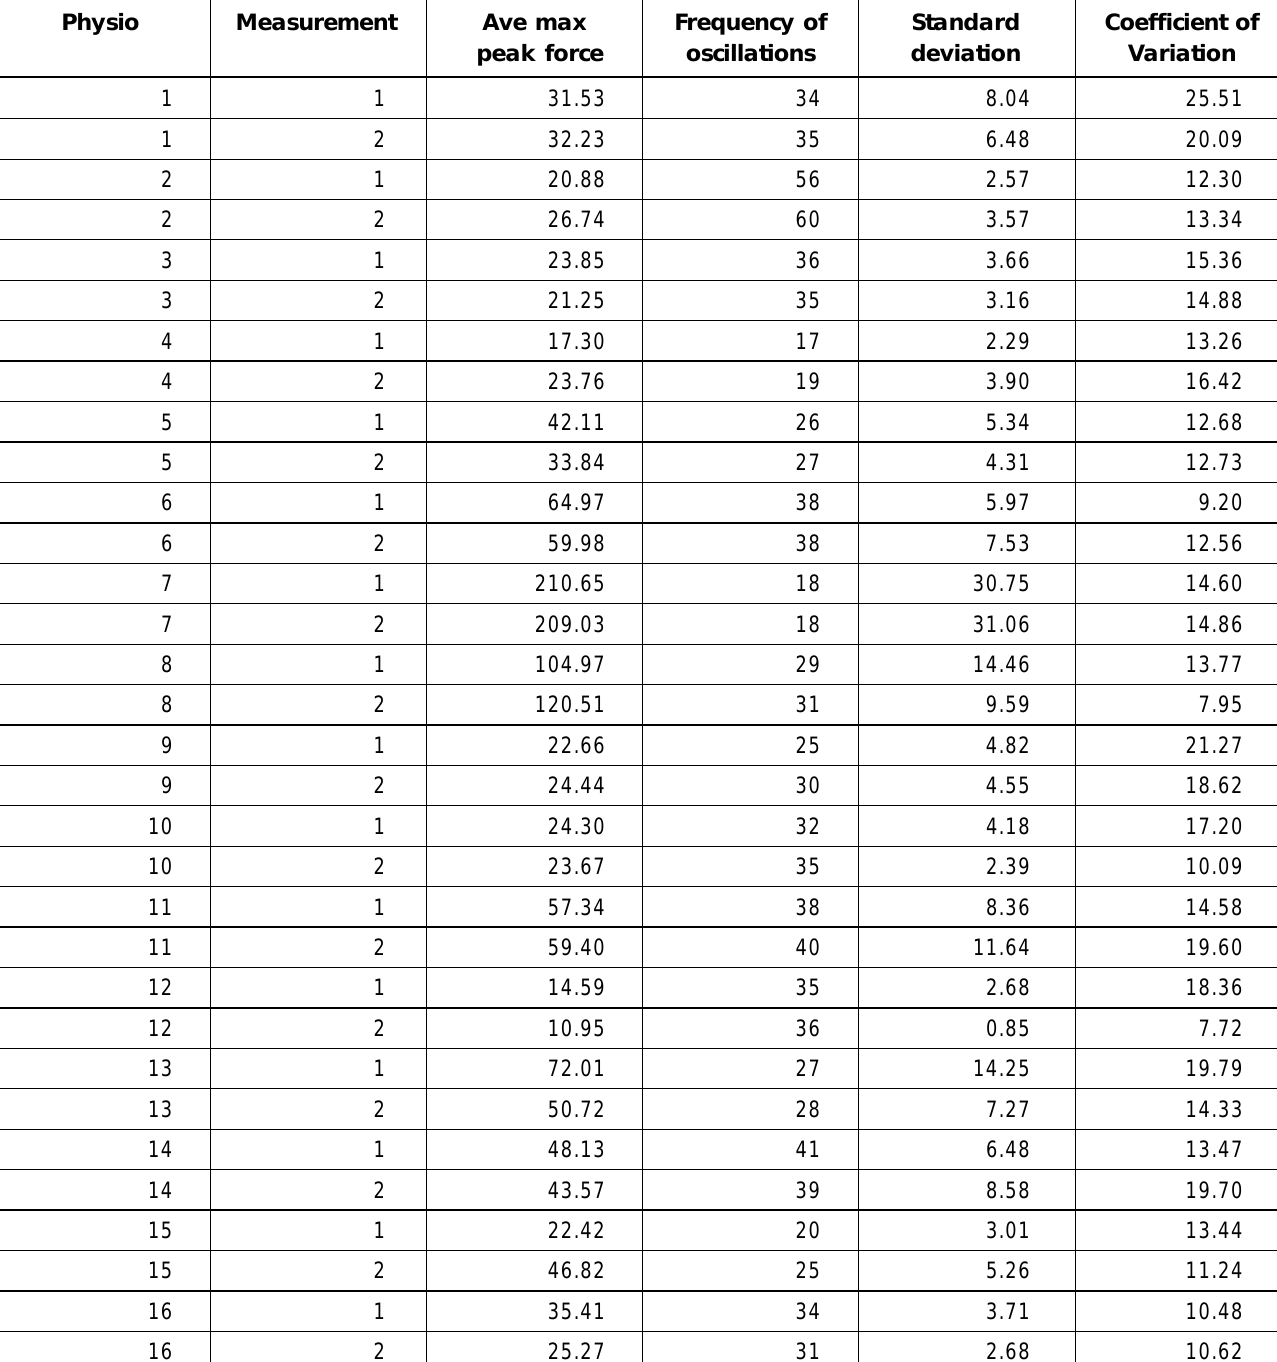
Table 1: The results of different variables for measurement one and two during a grade I p-a passive mobi- lization technique on C6, performed by 16